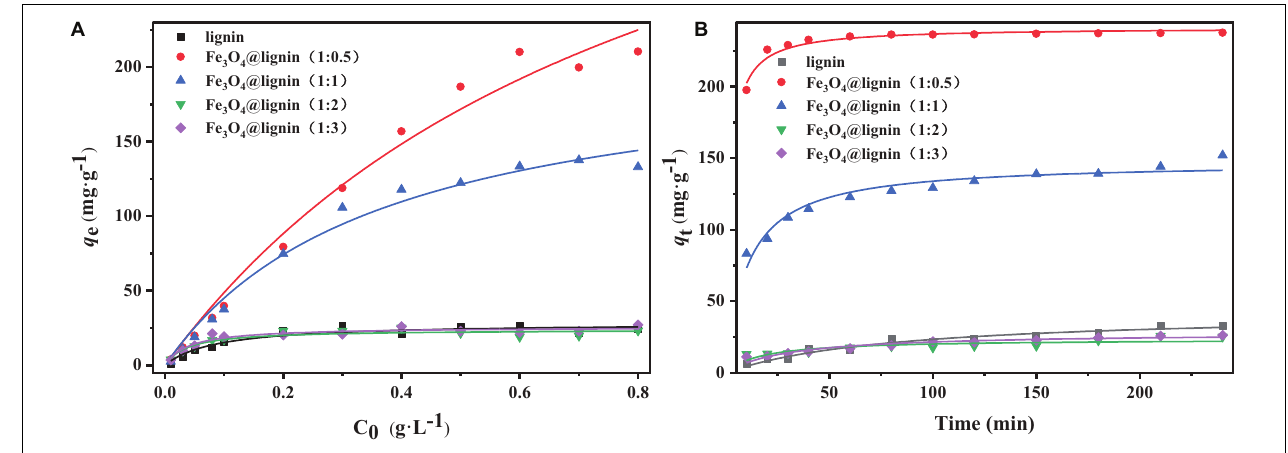
FIGURE 6 | (A) The adsorption kinetics of lignin and Fe 3 O 4 @ lignin composites for 4 h with different concentrations of Congo red solution. (B) The adsorption kinetics of lignin and Fe 3 O 4 @lignin composites for Congo red with a concentration of 0.6 g/L.